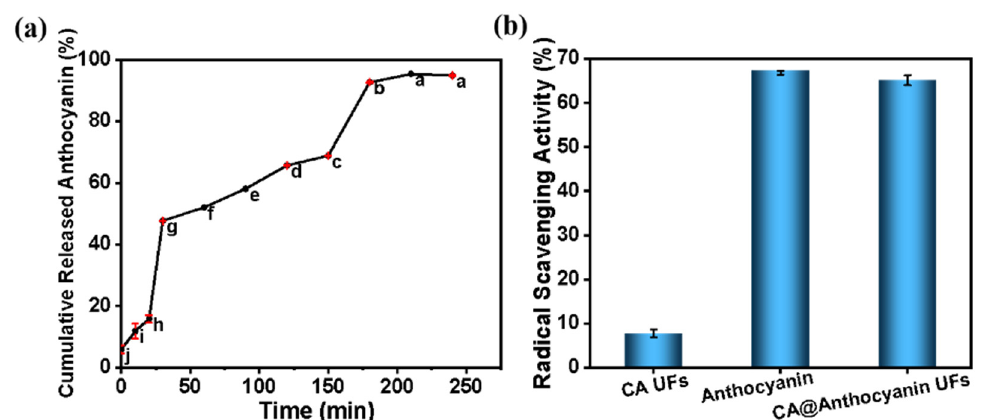
Figure 8. ( a ) Anthocyanin release profile from the CA@Anthocyanin UFs into the artificially simu- lated gastric fluid; ( b ) the DPPH radical-scavenging activities of CA UFs, the anthocyanin, and CA@Anthocyanin